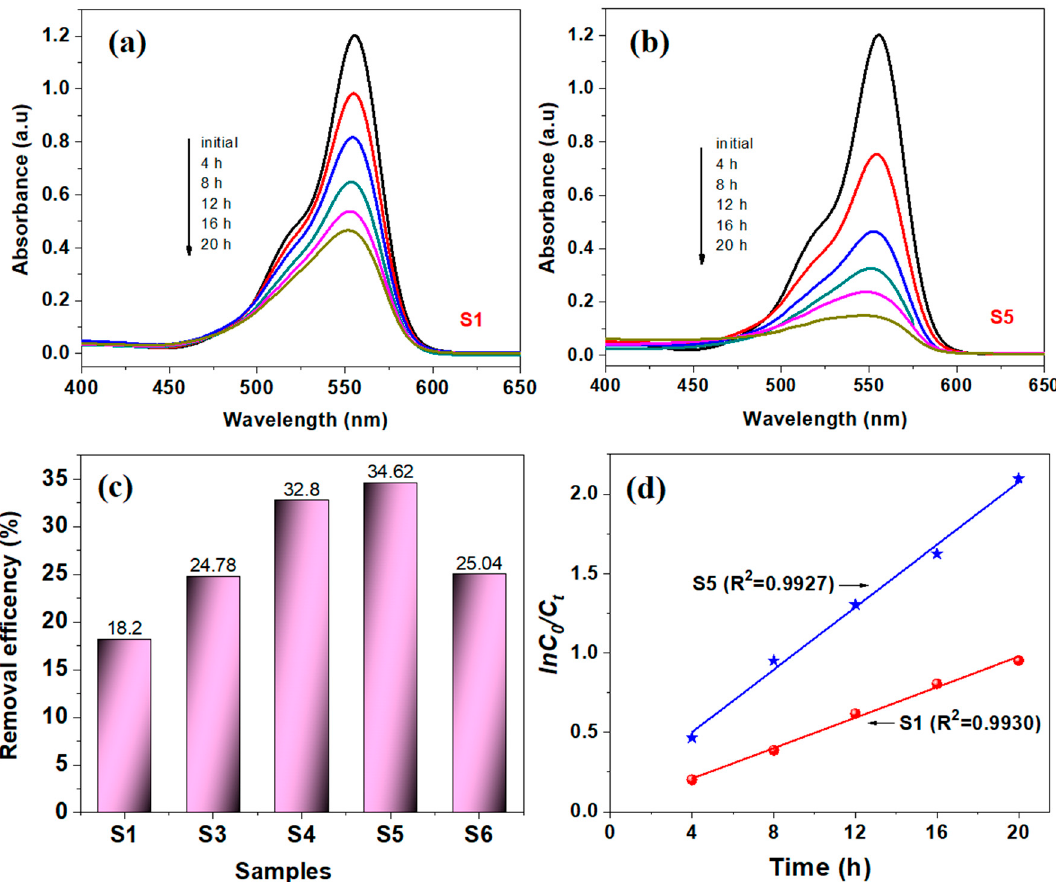
Figure 11. The absorption spectra changes of the RhB dye in aqueous solution, at various times, upon exposure to visible light irradiation in the presence of pure ZnO (S1) ( a ) and ZnO:MoO3 (S5) ( b ) samples; Removal efficiency (%) of the degradation of RhB dye, after 6 h of visible light irradiation ( c ); Pseudo-first order kinetics for RhB dye degradation in the presence of S1 and S5 samples, respectively ( d ).